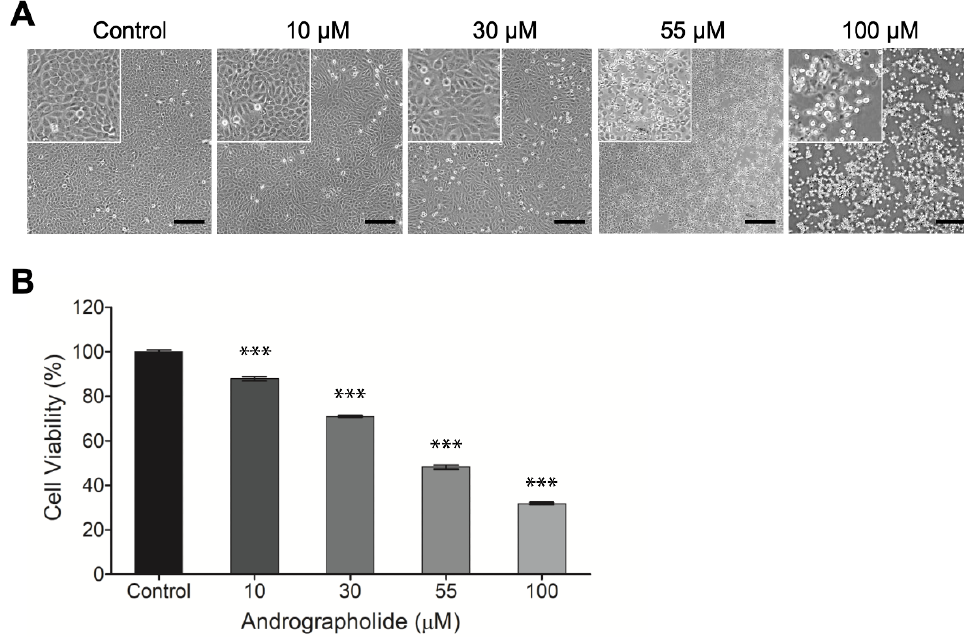
Figure 1. ( A ) Typical phase-contrast images of OEC-M1 cells cultured in 24-well cell culture plates 24 h after exposure to different concentrations (0, 10, 30, 55, and 100 µ M) of andrographolide. Cell number decreases as compound concentration increases. Cells exhibit a perceptibly distressed and shrunken morphology 24 h after exposure to 100 µ M of andrographolide. Images inside the top left small boxes are shown in 5x magnification. Scale bar = 200 μ m. ( B ) Change in cell viability of OEC ‐ M1 cells after treatment with andrographolide for 24 h at the indicated concentrations. Cell viability was evaluated by the alamarBlue assay. All treatments at higher concentrations significantly reduced cell viability relative to the control groups. Five independent experiments were performed ( n = 5), and the results are shown as means ± SEM. *** p < 0.001.